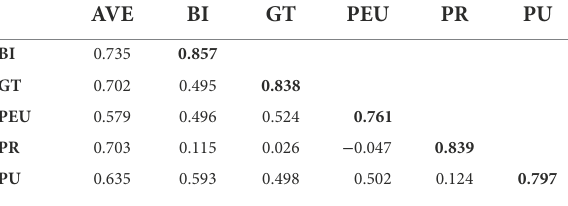
TABLE 4 Fornell–Larcker criterion.